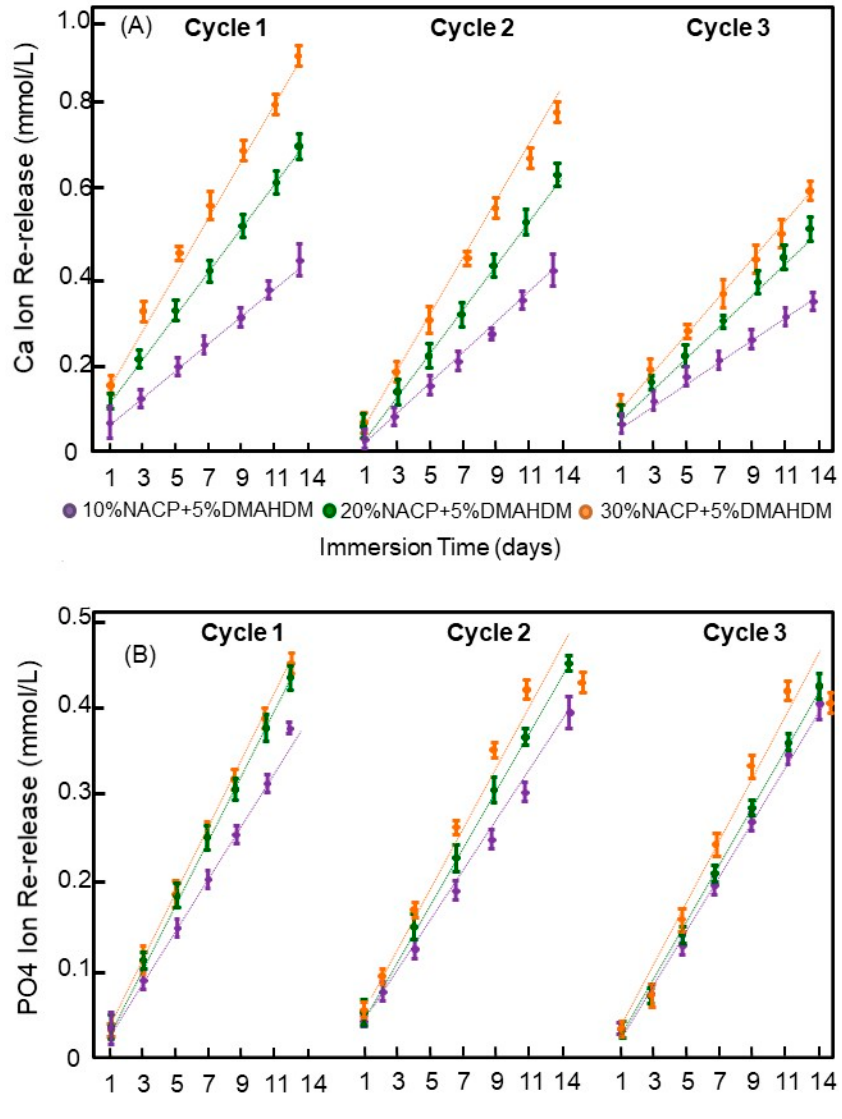
Figure 5. Cumulative ions re-release from the recharged resin dental sealants (Mean ± SD; n = 3) after three cycles of ions recharge and re-release. The dots for each group show the exact data and the dotted line is its approximate linear trend for each formulation. In ( A ), Calcium ion and in ( B ) Phosphate ions. There was no decrease in the ion re-release amounts with increasing the number of recharge and re-release cycles.